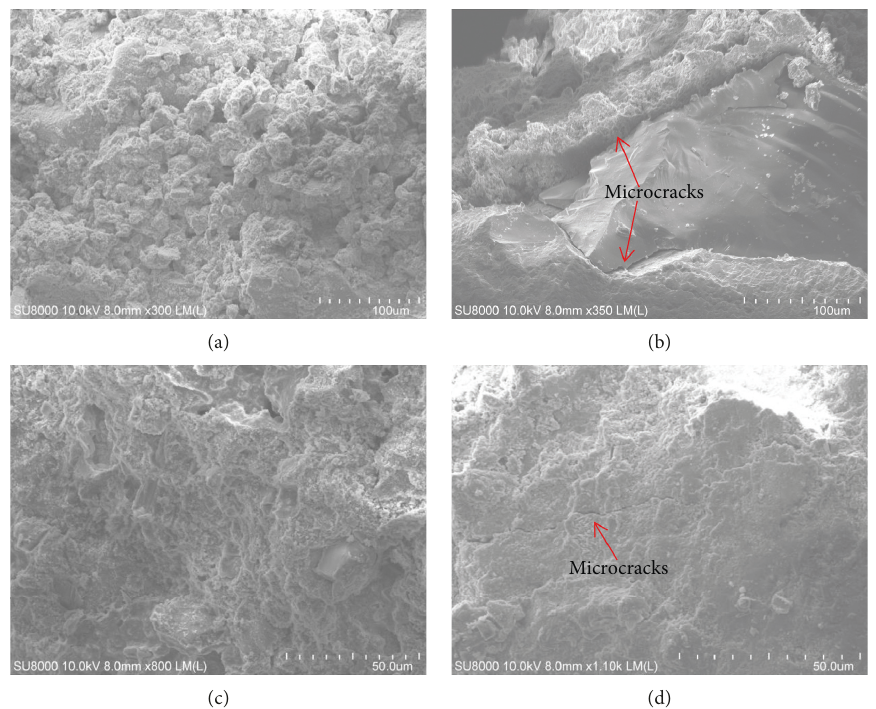
Figure 13: SEM results of cracks surface of shale-like material after creep experiments. (a) Room temperature, confining pressure 0 MPa. (b) Temperature 60 ° C, confining pressure 0 MPa. (c) Room temperature, confining pressure 7 MPa. (d) Temperature 60 ° C, confining pressure 7